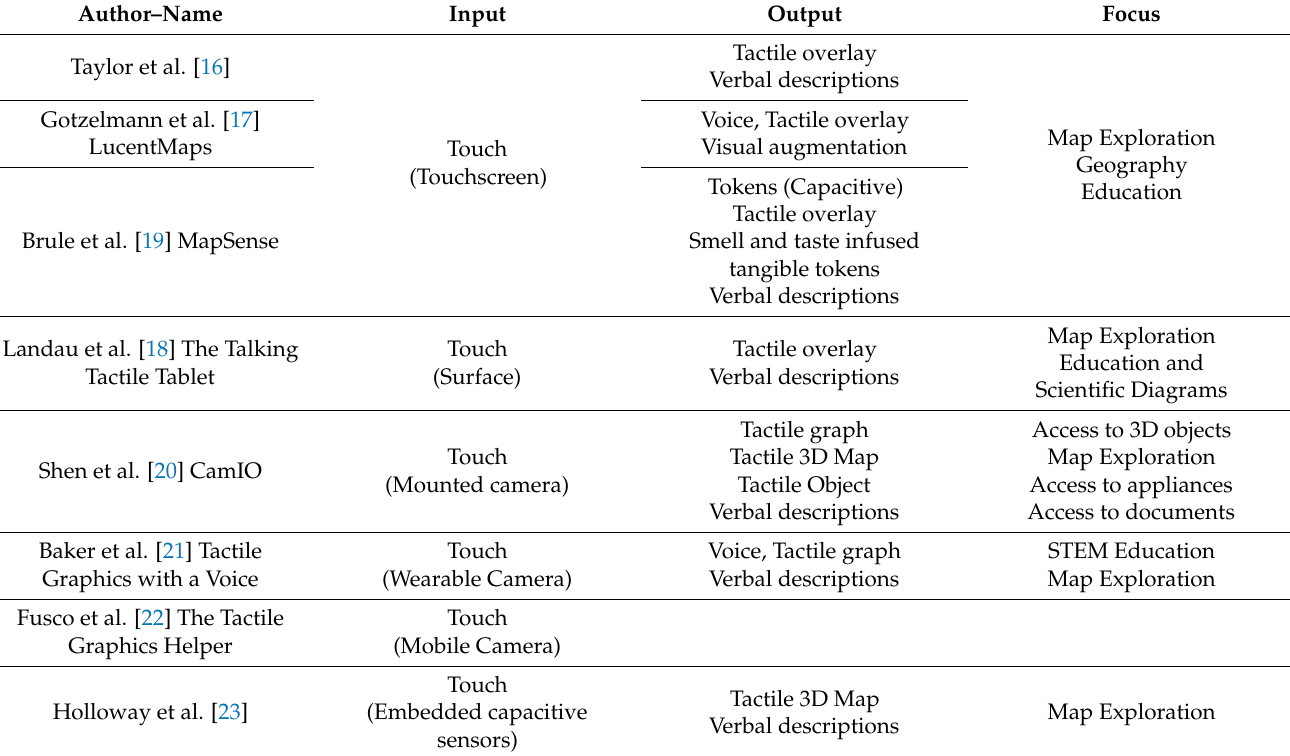
Table 1. Interactive Tactile Graphics and Multimodal Guide for educations and map